Question: Based on the figure, does the quantity rise or fall?
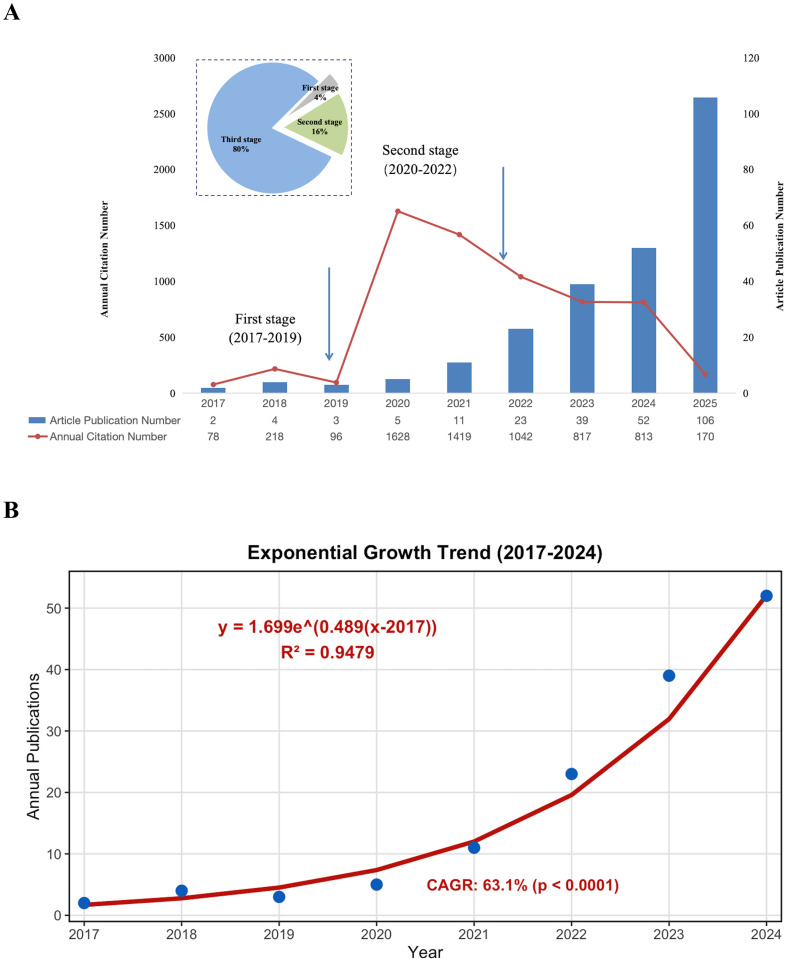
Answer: increasing